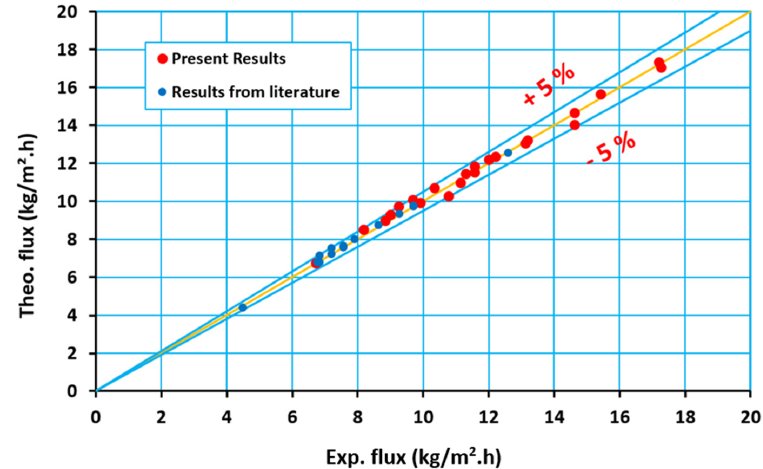
Figure 15. Model prediction results against the experimental data of the permeate flux.